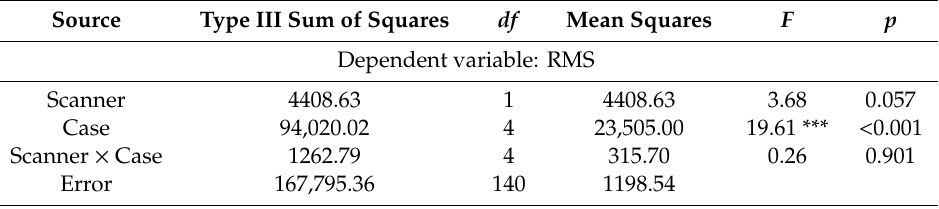
Table 1. Results of two-way ANOVA with the root mean square (RMS) as the dependent variable. Source Type III Sum of Squares df Mean